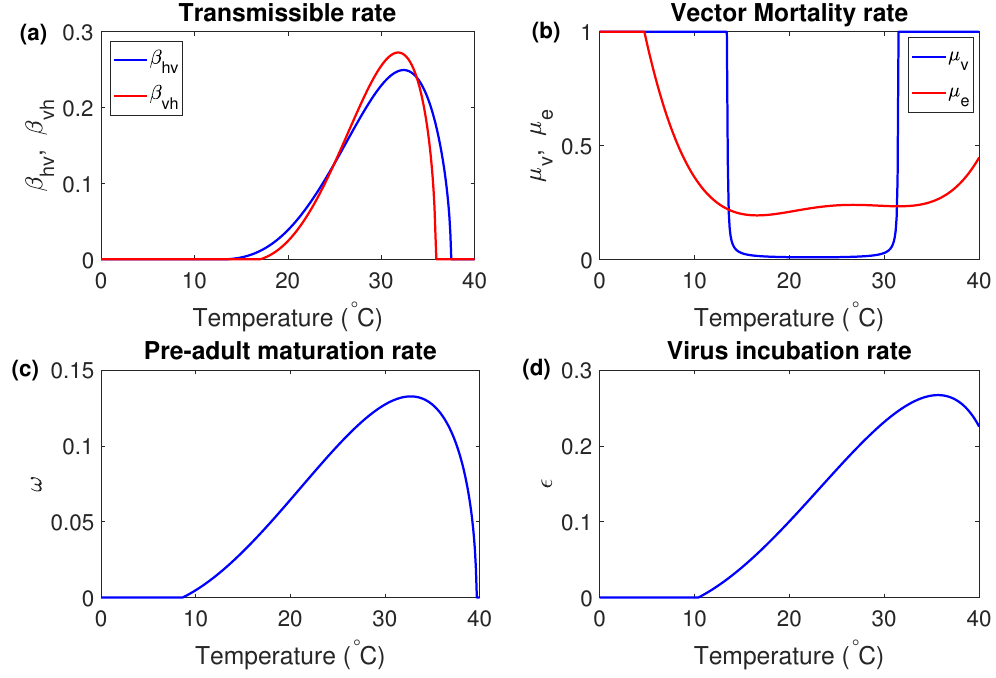
Figure 2. Plots of the temperature-dependent parameters; ( a ) transmissible rates β hv and β vh , ( b ) vector mortality rates µ v and µ e , ( c ) pre-adult maturation rate ω and ( d ) virus incubation rate (cid:101)